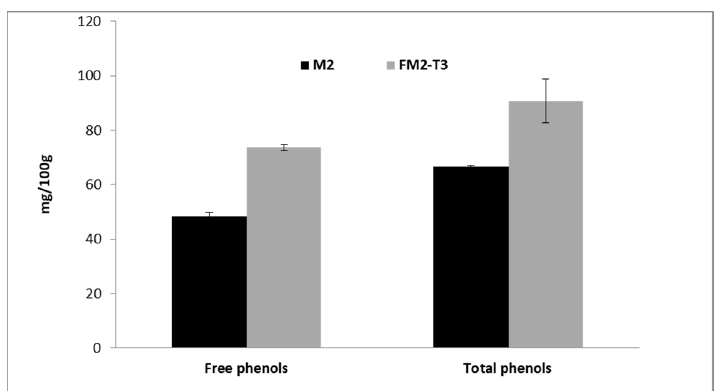
Figure 4. Free and total phenolic amount, by acidic hydrolysis, before and after fermentation in M2 sample. The fermented sample was withdrawn after 72 h of fermentation. Data are expressed in mg/100 g as a mean of three independent extraction.